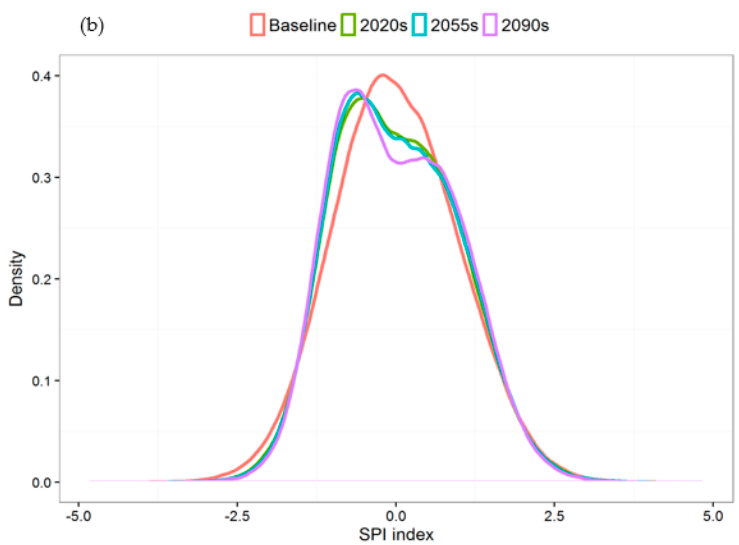
Figure 7. Meteorological (three-month) drought indices for three grids (South East, Middle, and North West of the Brazos Headwaters Basin) calculated based on baseline and projected rainfall for the 2090s period ( a ); and probability distribution of metrological drought for future periods ( b ).